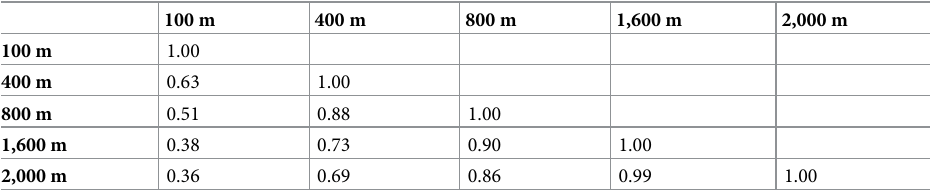
Table 3. Pearson correlations between mean NDVI across different buffers.